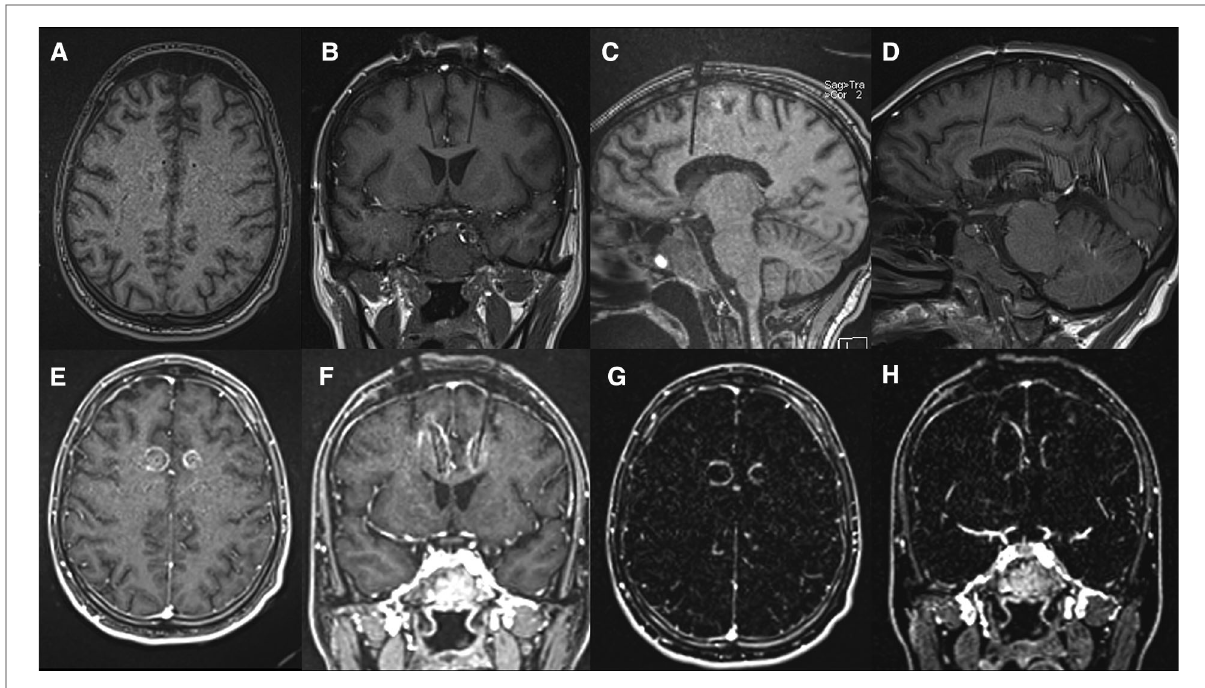
FIGURE 4 ( A – D ) Pre-ablation T1 sequences obtained for con fi rmation of the laser catheter location immediately before ablation. Axial ( A ), Coronal ( B ) and Sagittal ( C – Left and D – Right); ( E – H ) Post-ablation T1+C axial ( E ) and coronal ( F ) images and MRI subtraction, [i.e. (T1+C)-T1] axial ( G ) and coronal ( H ) slices ( G,H ) demonstrating the area of tissue damage highlighted by surrounding ring